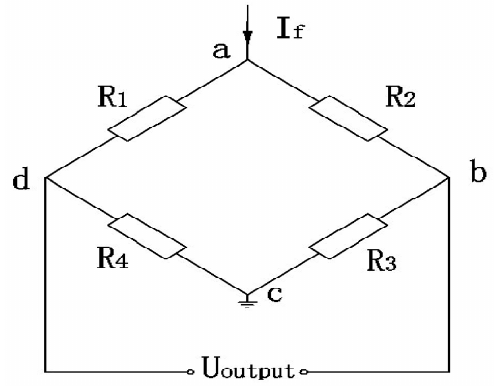
Figure 2. Configuration of the piezoresistive pressure sensor.